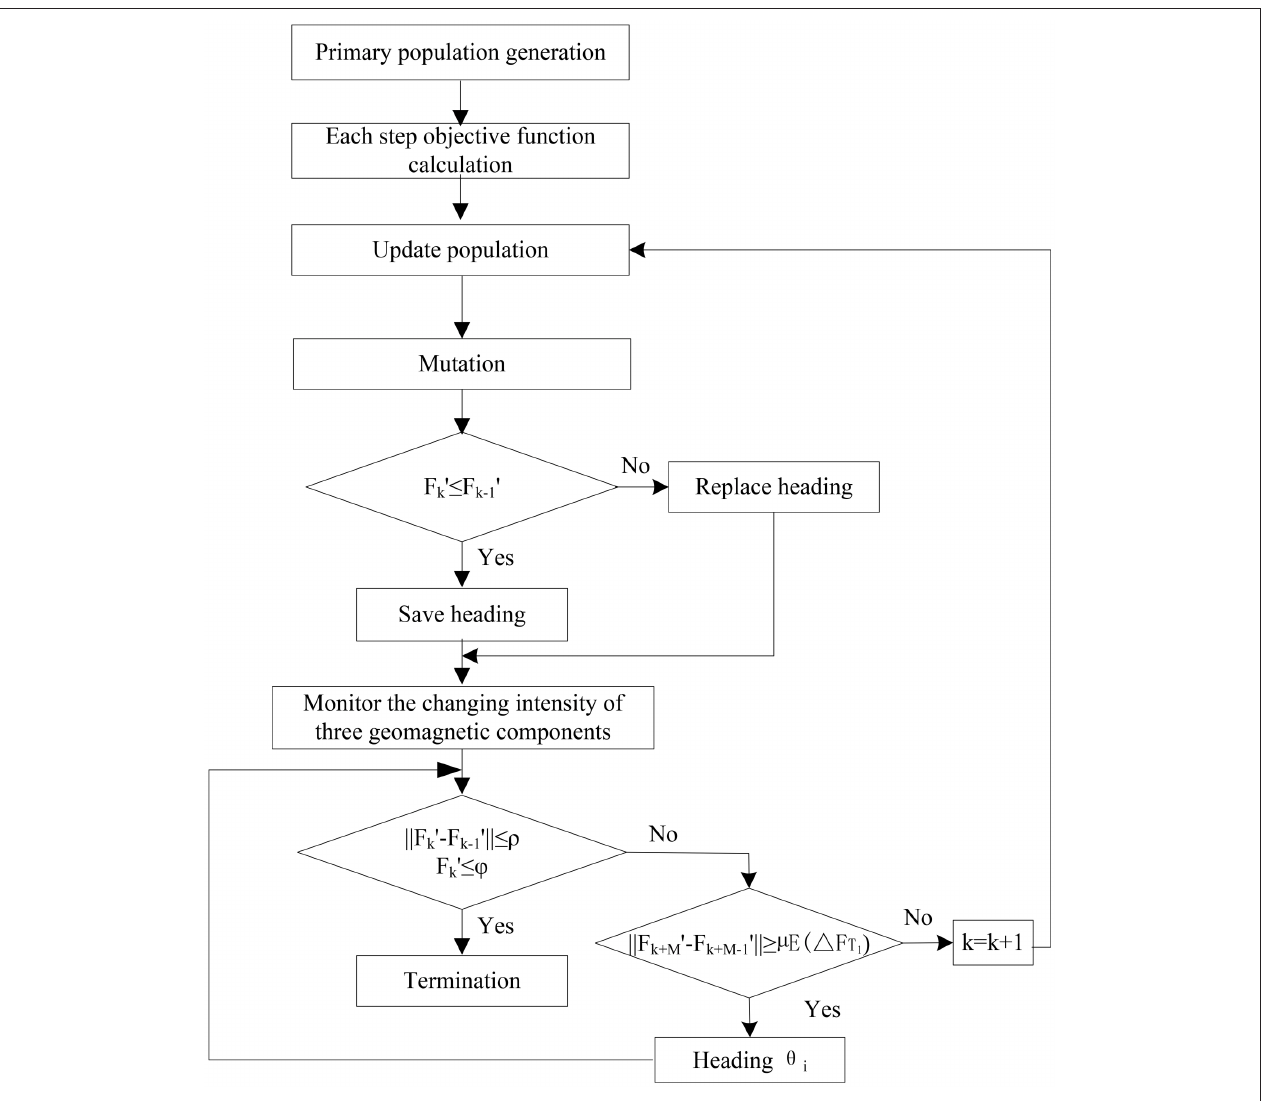
FIGURE 2 | The workflow of the evolutionary search within geomagnetic